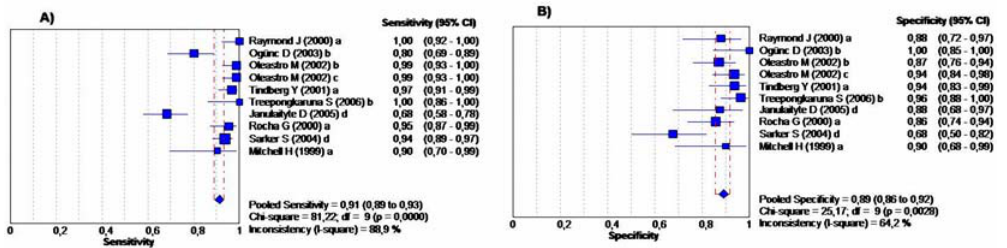
Figure 3. Summary Receiver Operator Curve (SROC) for Serum IgG-ELISA Diagnostic Tests. Each solid square represents an individual study in the meta-analysis. The curve is the regression line that summarizes the overall diagnostic accuracy. AUC=area under curve, SE (AUC)=standard error of AUC, Q*=index defined by point of the SROC curve where the sensitivity and specificity are equal; SE (Q*)=standard error of Q*